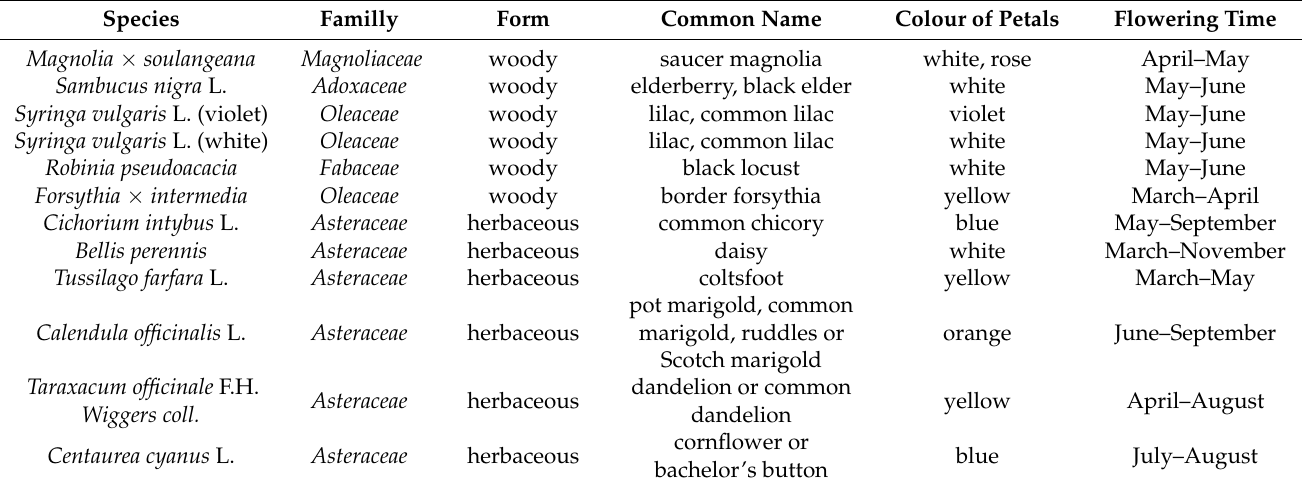
Table 1. Characteristics of edible